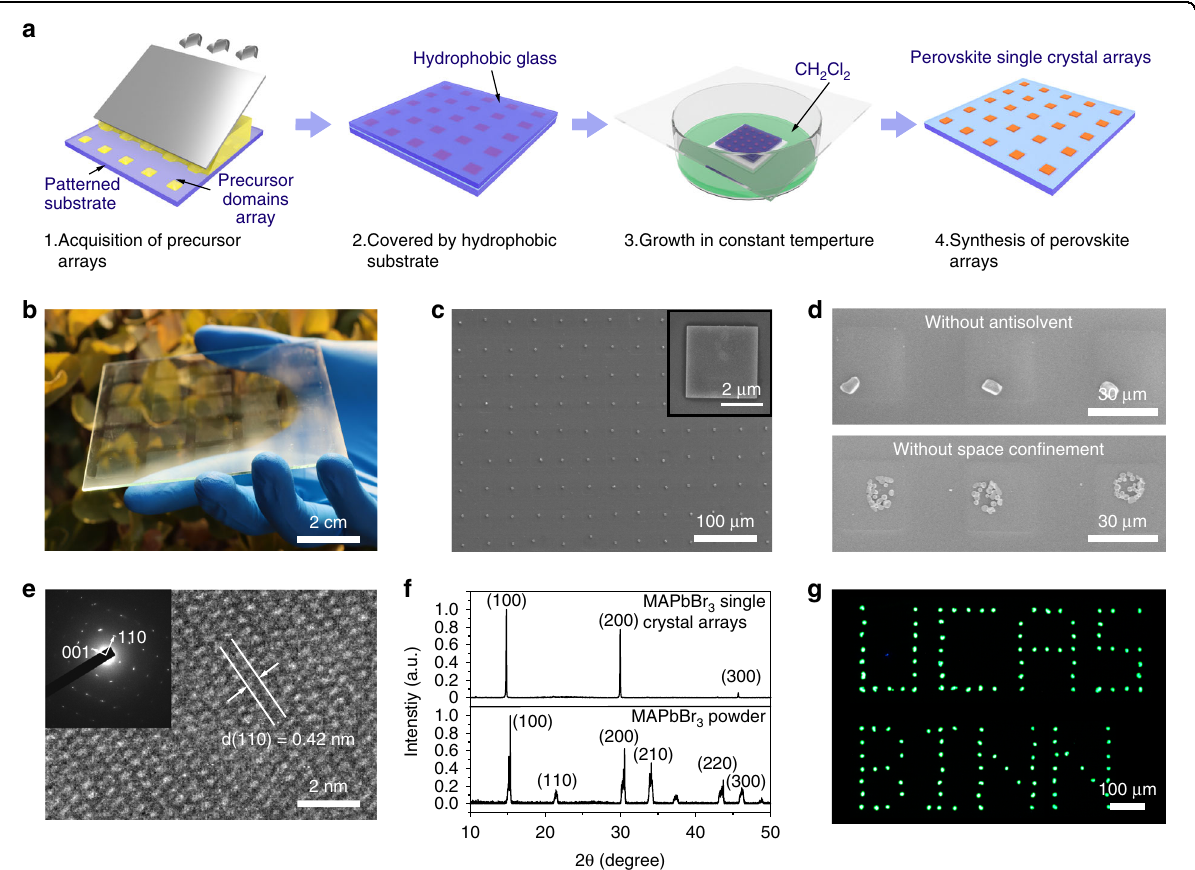
Fig. 1 Fabrication process and structural characterization of perovskite MPs array. a Schematic illustration for the synthesis process of perovskite MPs array. b Optical image of the MAPbBr 3 MPs array fabricated on the 10 × 10 cm glass. c SEM image of MAPbBr 3 MPs array. The inset is an enlarged view of an individual MAPbBr 3 MP. d SEM images of MAPbBr 3 single crystal array fabricated without antisolvent (top) and space con fi nement (bottom). e HRTEM image of a single MAPbBr 3 MP. The inset is SAED patterns. f X-ray diffraction of as-synthesized MAPbBr 3 MPs array and MAPbBr 3 powder. g Fluorescence micrograph of the MAPbBr 3 MPs array under 365 nm light illumination showing the bright green pattern of the “ BINN ” and “ UCAS